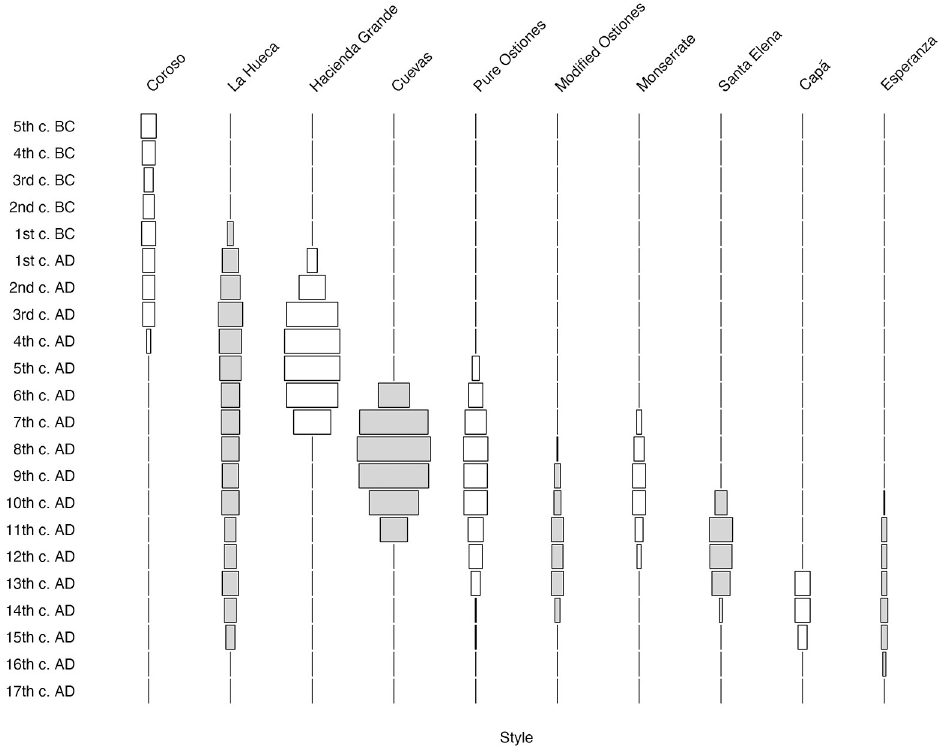
Fig 17. Battleship curves (count by century) of modeled and calibrated dates (mcal) for 10 Rousean styles. Note that Coroso style’s duration is artificially begun in the 5 th century B.C., as its prolonged duration (over 4000 years) otherwise distorts scale of figure to such a degree as to make it useless. Moreover, 100% of dates prior to 5 th century B. C. belong to Coroso style.